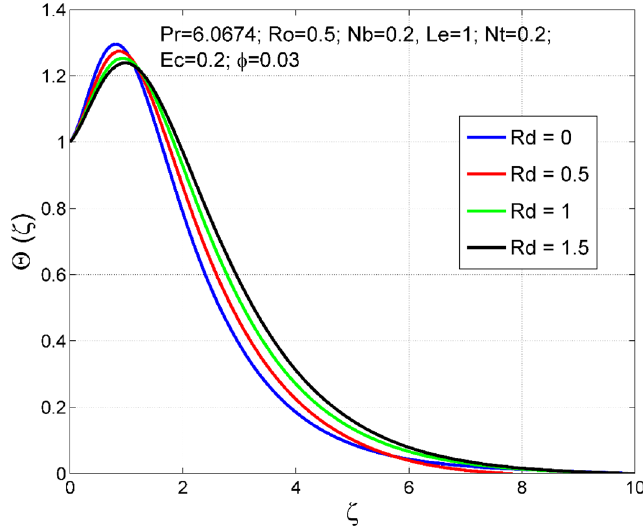
Figure 13. Effect of Rd on �(ζ) .